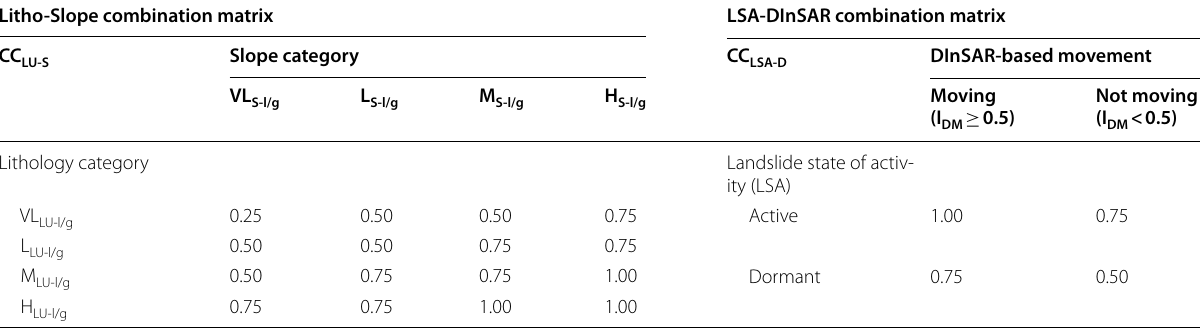
Table 1 Values of correction coefficients (CC combination